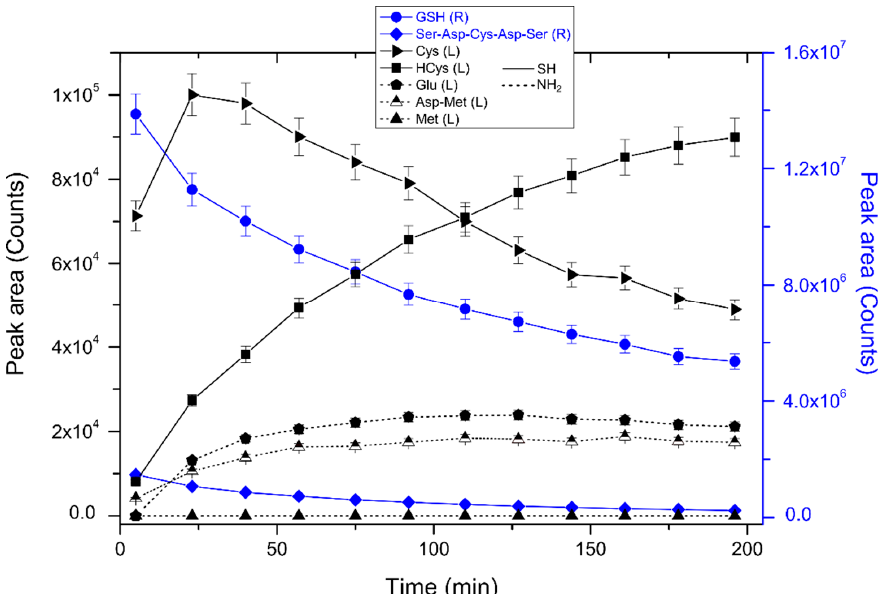
Figure 2. Peak area of tested derivatized compounds at different incubation times. Compounds reacting with 4MeQ on their sulfur group are connected using lines (GSH, Cys, HCys and Ser ‐ Asp ‐ Cys ‐ Asp ‐ Ser) while these reacting on their amino group are connected using dots (Met, Glu and Asp ‐ Met). Plots in black correspond to Y ‐ left axis and plots in blue to Y ‐ right axis.